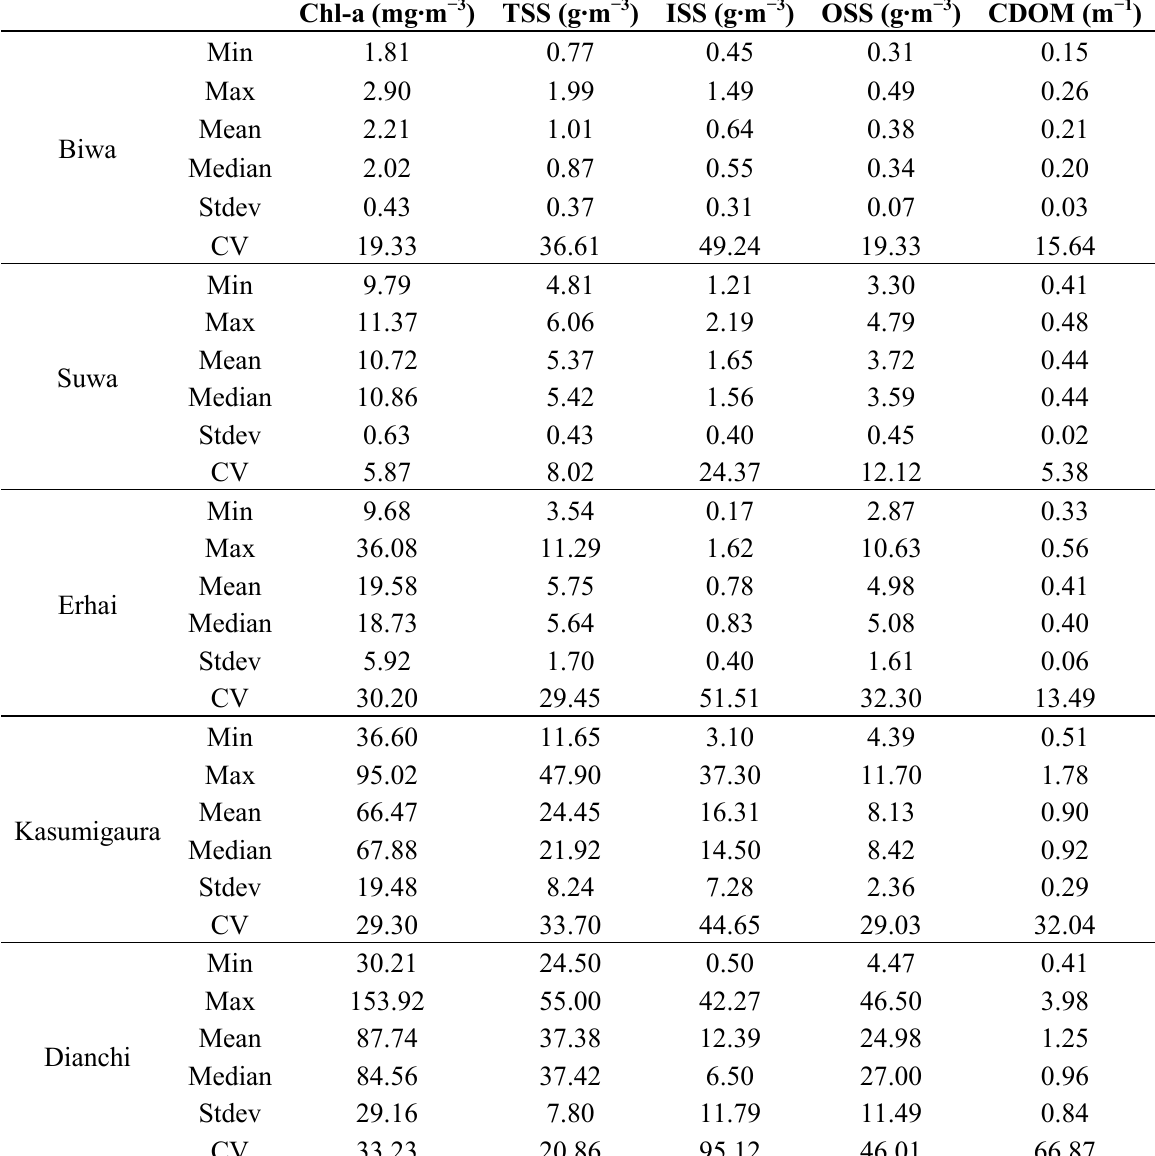
Table 1. Statistical description of water constituent concentrations for Lakes Biwa, Suwa, Erhai, Kasumigaura and